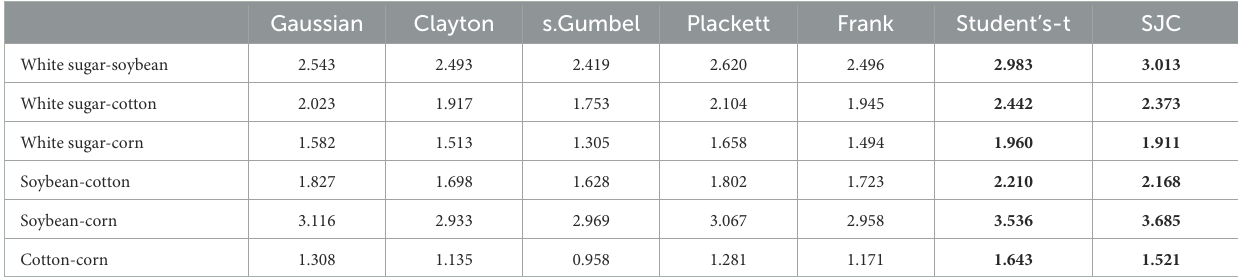
TABLE 3 Average log likelihood for the seven